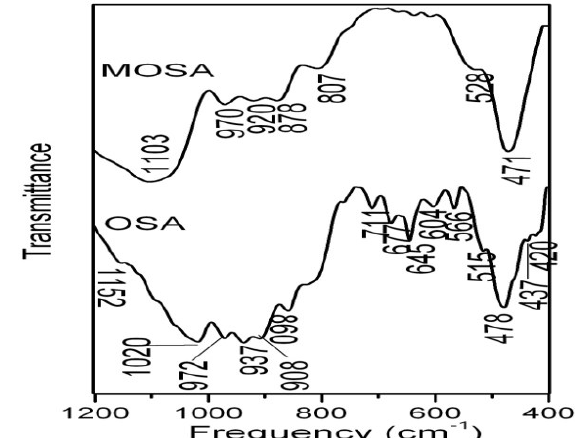
Figure 4. FTIR spectra of the firing oil shale (OSA) and the modified oil shale ash